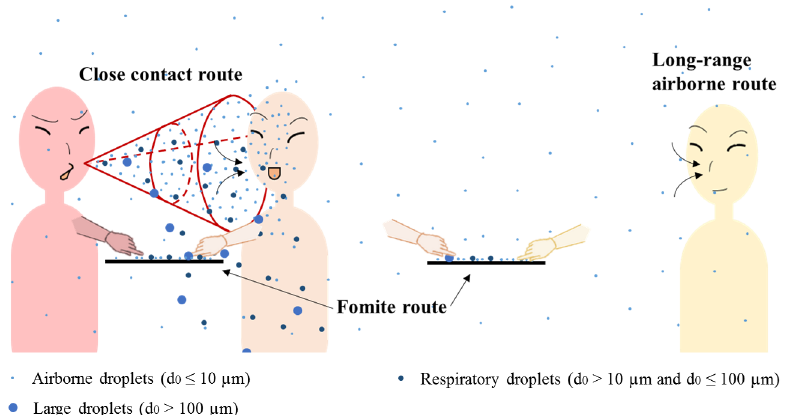
Fig 1. The three major transmission routes: Long-range airborne, close contact and fomite. The personin red is the index patient.